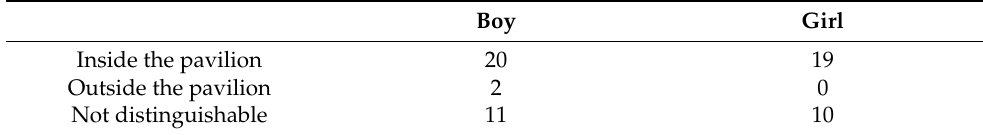
Table 2. Location of the space represented.